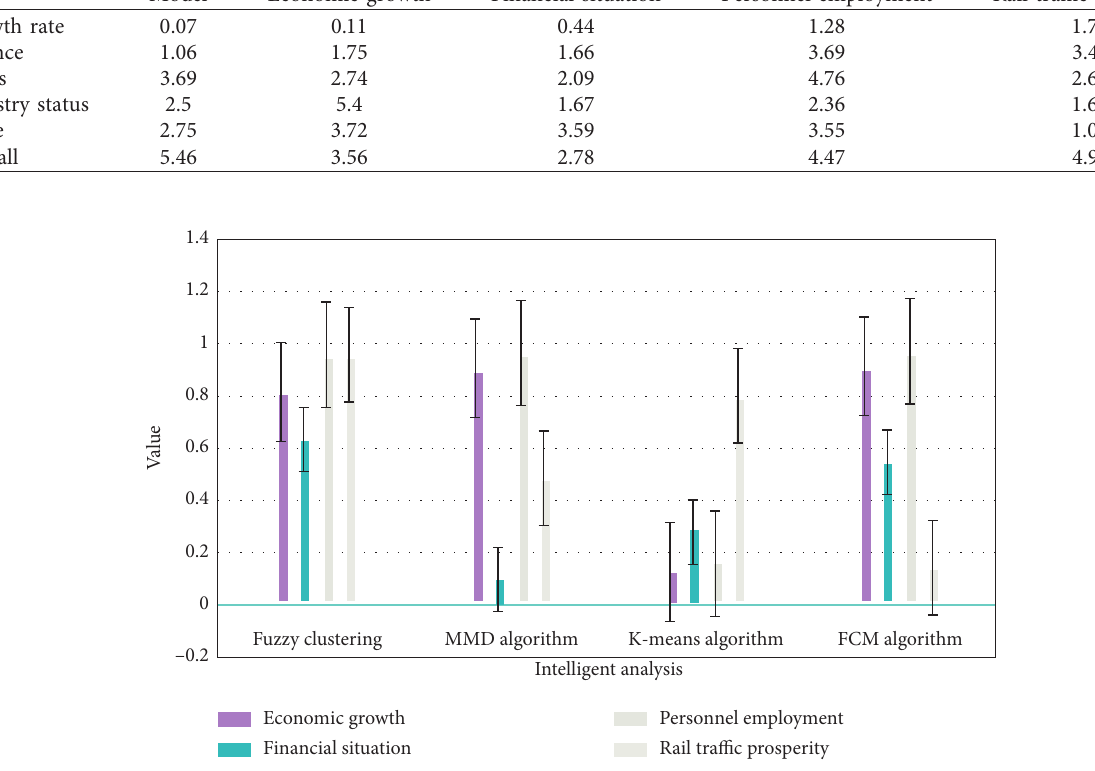
Figure 2: Analysis diagram of three indicators by different intelligent analysis